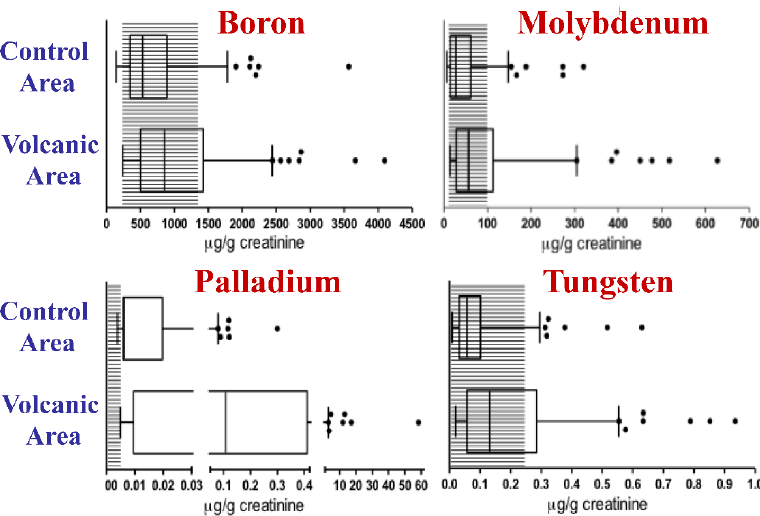
Figure 2. Metal biocontamination in the urine of residents of the volcanic area. The concentrations of boron, molybdenum, palladium, and tungsten were measured in the urine of 140 residents of the volcanic area and of 138 residents of the control area in Sicily. Data obtained from [81]. For B, Mo, Pd and W concentrations were significantly higher in the urine of residents of the volcanic area than in that of residents of the control nonvolcanic area and exceeded the normal reference values in over 20% of cases. The boxes indicate the 25th, 50th (median), and 75th percentiles. The whiskers indicate the 5th and 95th percentiles. The shaded area indicates the Italian reference values for urine. The dots indicate individuals with urinary concentrations higher than the 95th